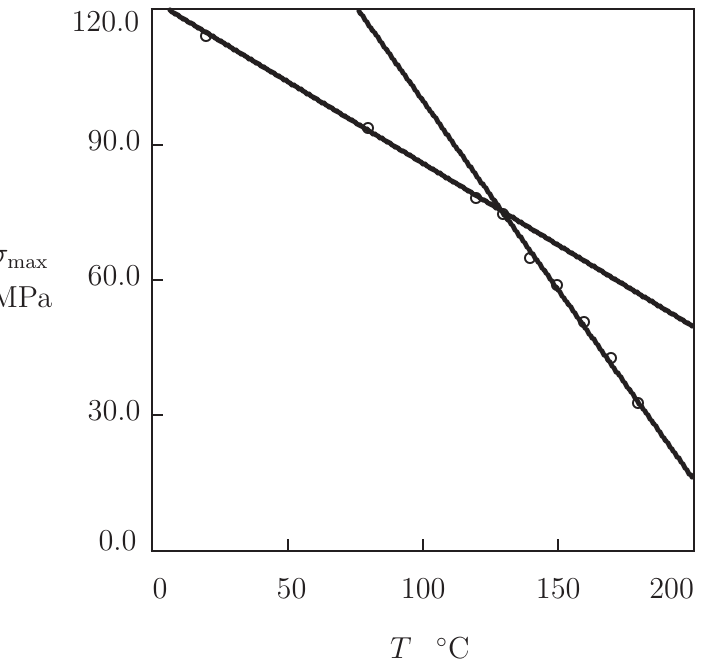
Figure 3. Tensile strength σ max versus temperature T . Circles: experimental data in tensile tests with strain rate ˙ (cid:101) = 3.1 10 − 3 s − 1 . Solid lines: approximation of the data by Equation ×